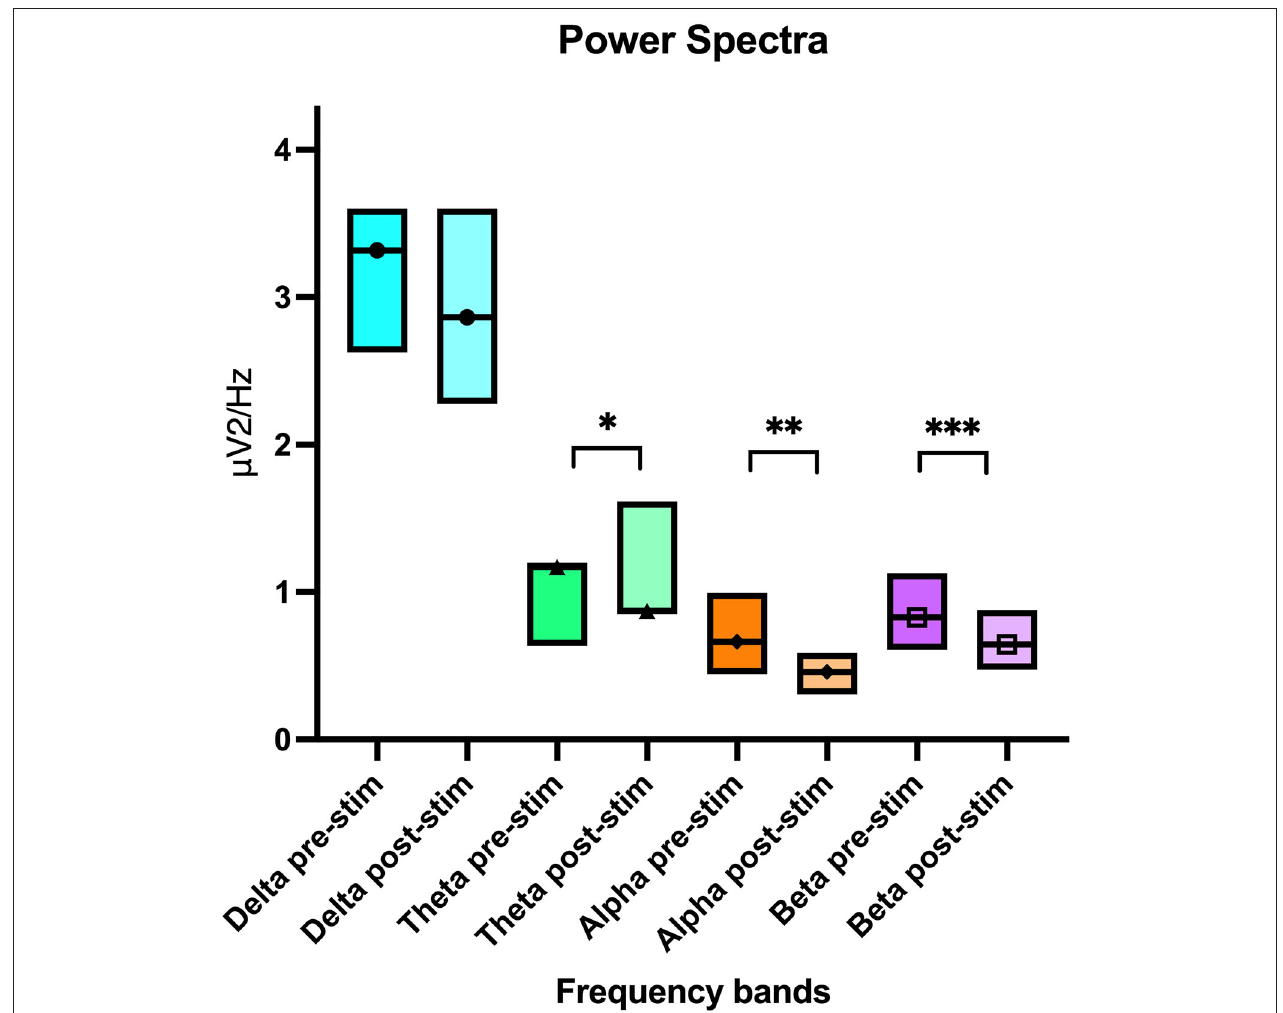
FIGURE 7 | Boxplot graph showing the pooled power spectral analysis mean value per electroencephalogram frequency band with the upper and lower confidence intervals. The line crossing the boxes indicate the median value obtained in that frequency band. An * denotes statistical significance of p = 0.01, ** significance of p < 0.01 and *** significance of p =